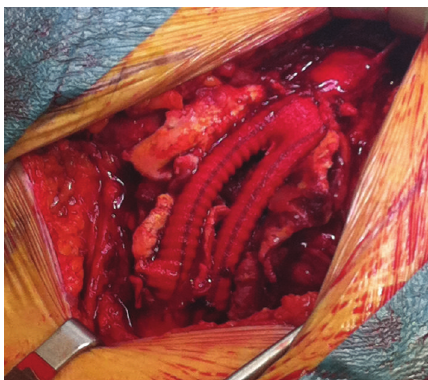
Figure 3: Intraoperative image of the 12 × 6mm Dacron bifurcated bypass grafting from the proximal common femoral artery to the distal segment of the profunda and superficial femoral artery,